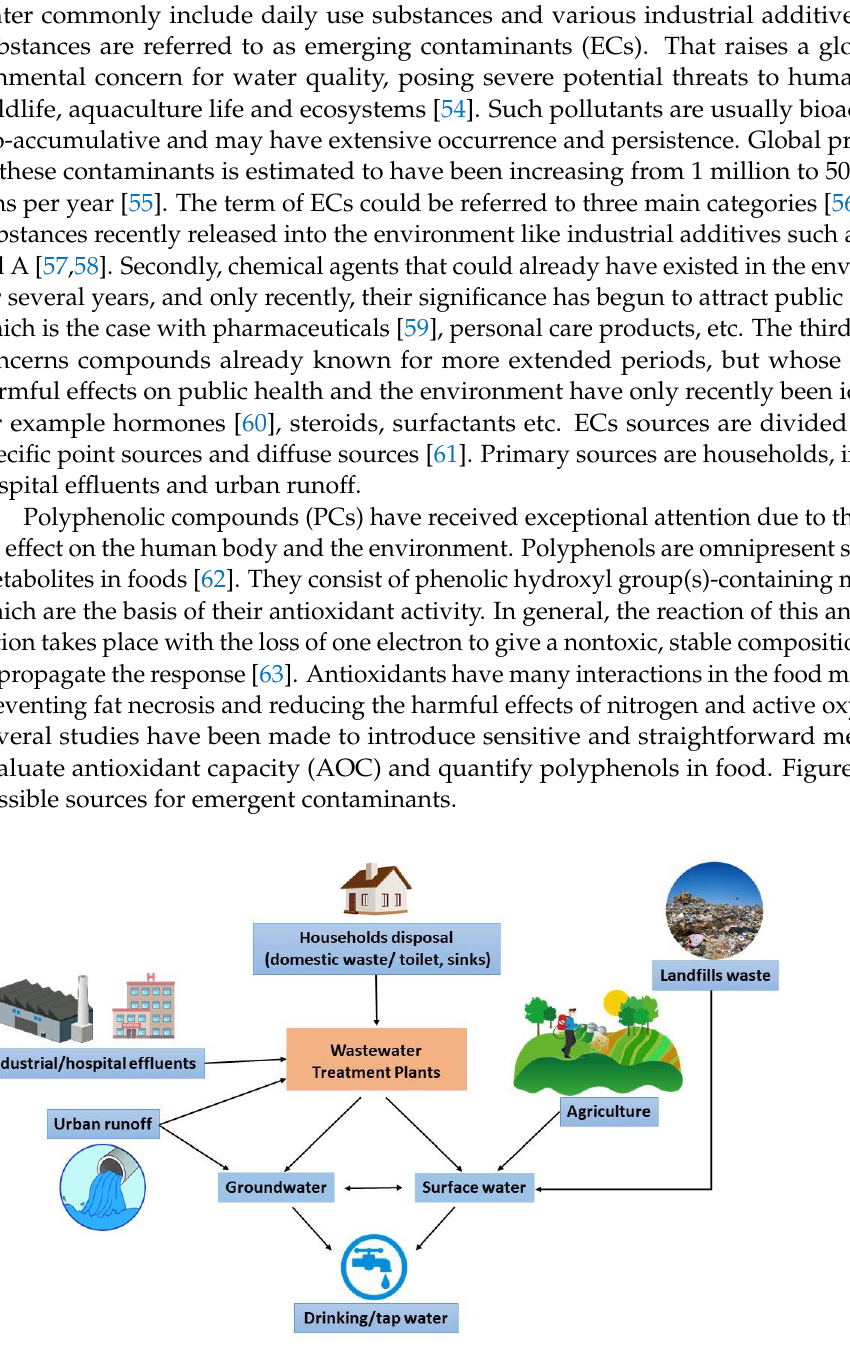
Figure 1. Primary sources of water contaminants in the environment.